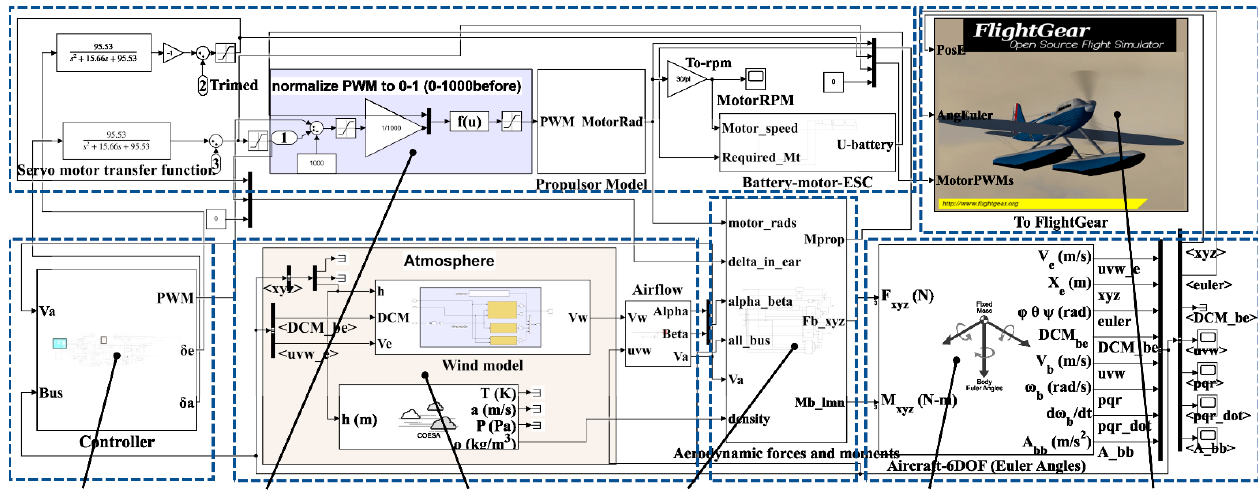
Figure 19. The nonlinear Simulink model of the fixed-wing UAV.